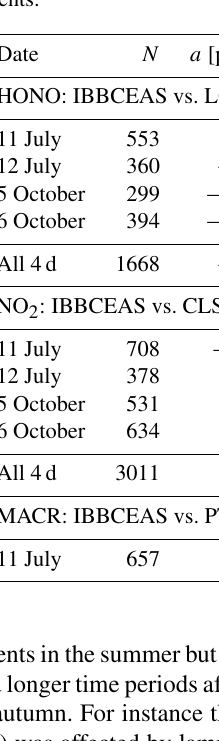
Table 1. Comparison of correlation plot data. N : number of data points; a and b : regression coefficients; σ(a) and σ(b) : bootstrap errors of the linear square fit y = a + bx (where y represent IBBCEAS data [pptv] and x the data [pptv] by either LOPAP, CLS, or PTRMS); r : Pearson linear correlation